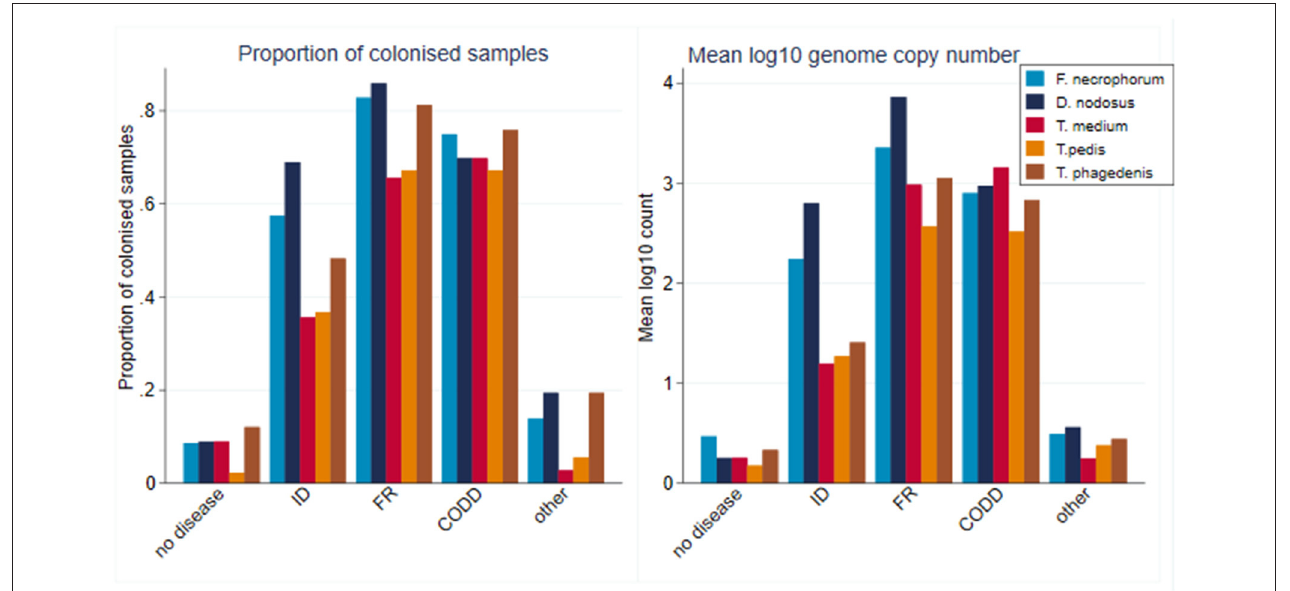
FIGURE 6 | Proportion of colonized samples and mean log 10 MGCN by recorded clinical lesion ( n = 30 sheep, n = 120 feet).